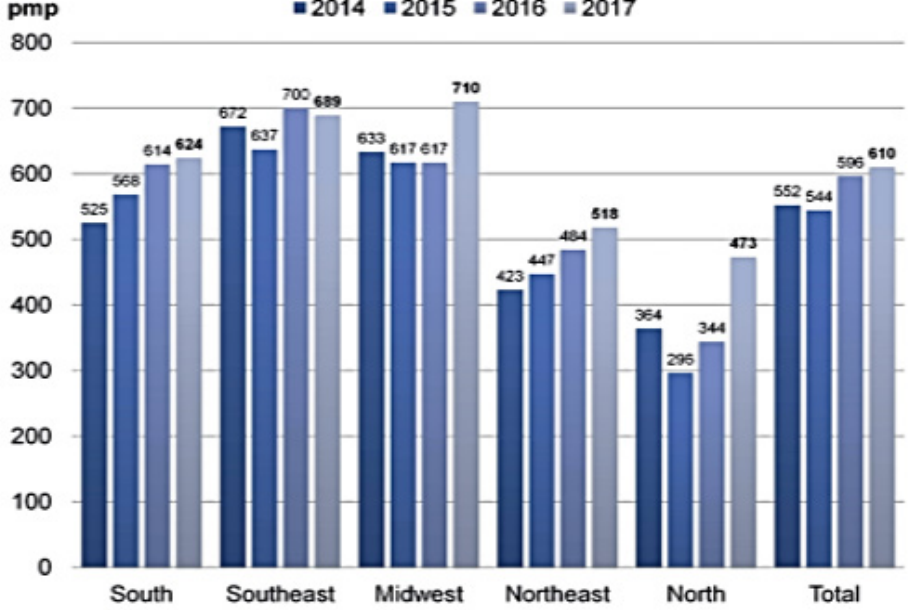
FIGURE 1 - Estimated prevalence of dialysis patients in Brazil, by region in the period of 2014-2017 (SOURCE: Adapted from Thomé et al. ,